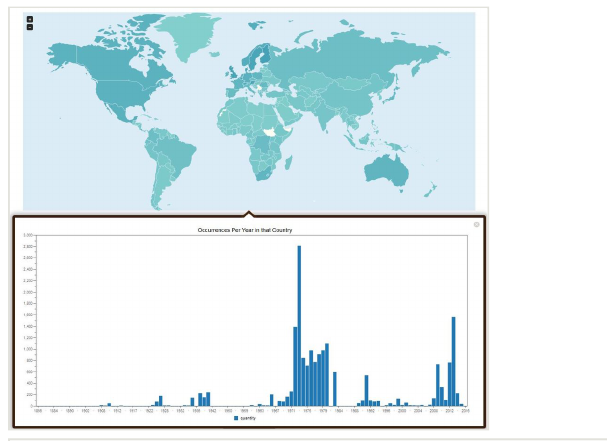
Figure 4. Visualisation of Lepidoptera density occurences: World Map (darker colors indicate a higher number of occurrences) and Lepidoptera occurences chart bar per year, exempli fi ed with the country data of Germany (EU BON European Biodiversity Portal, beta version